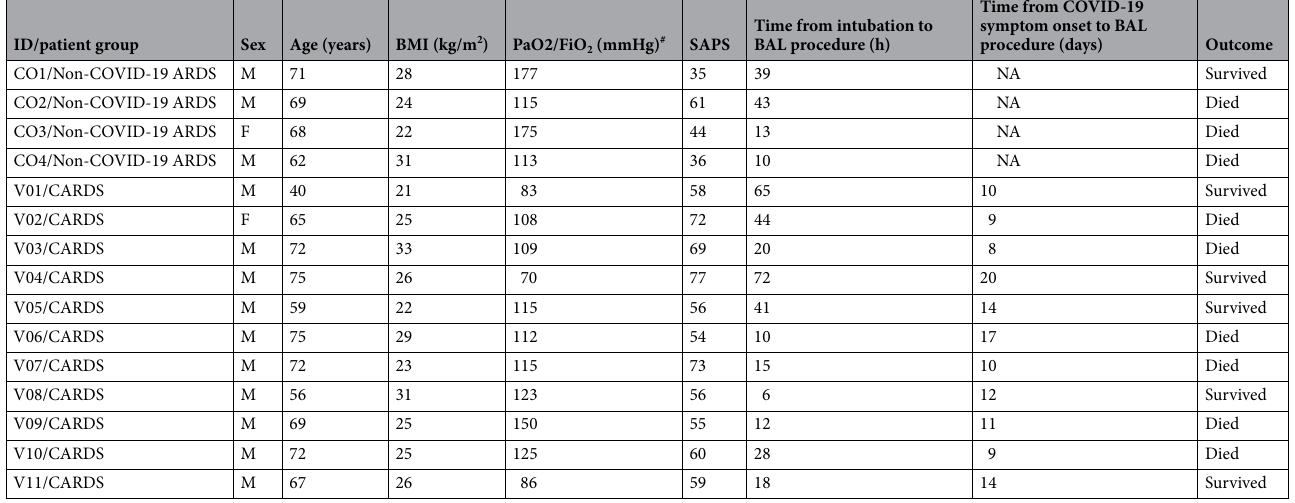
Table 1. Clinical characteristics of patients with CARDS and non-COVID-19 patients. ARDS, acute respiratory distress syndrome; BAL, bronchoalveolar lavage; BMI, body mass index; DXM, dexamethasone; F, female; M, male; PaO2/FiO2, ratio of PaO2 (mmHg) to fractional inspired oxygen; SAPS, simplified acute physiology score.